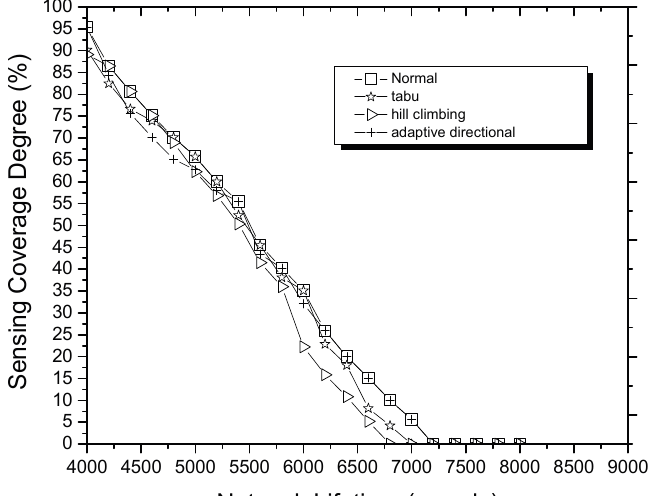
Figure 9. Performances of the dynamic local search strategy in the different